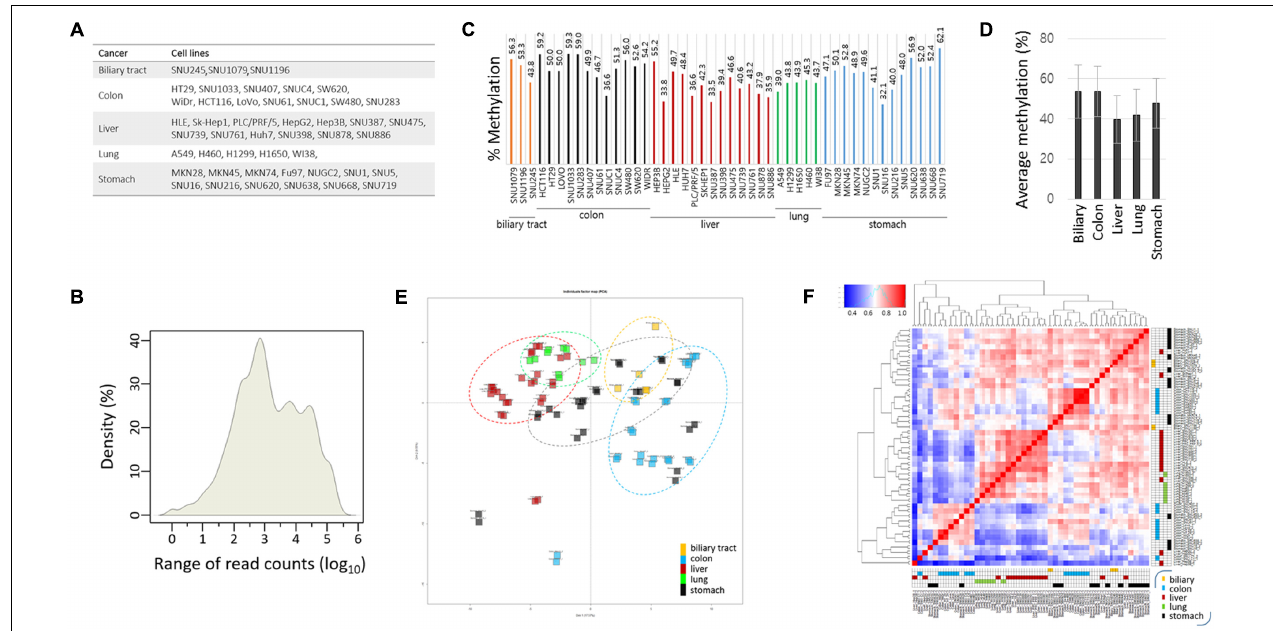
FIGURE 2 | Targeted bisulfite PCR sequencing statistics and correlation analysis. (A) List of cancer cell lines used in TBPseq. (B) Kernel density plot of read counts from the whole cancer samples. Individual target sequences have various read counts ranging from several 10s to 100s of 1000s. The mean methylation levels of target sequences in individual cancer cell lines (C) and in groups (D) . Error bars, standard deviations. (E) Principal compartment analysis (PCA). Different cancer cell groups are circled in different colors. The intimate proximity of sample replicates on the PCA plot demonstrates the reproducibility and reliability of TBPseq method. (F) Unsupervised hierarchical clustering of Pearson correlation for target CpG methylation levels among cancer cell lines. Each cancer cell line is distinctively colored by the cancer type: yellow, biliary tract cancer; blue, colon cancer; red, liver cancer; green, lung cancer; black, stomach